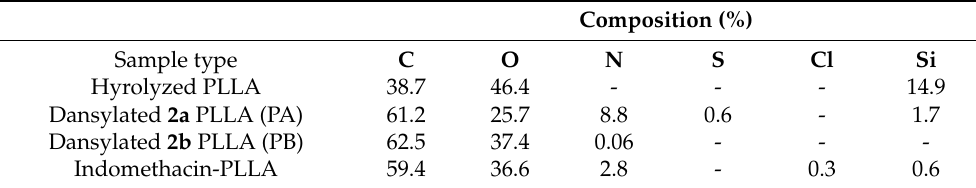
Table 2. The atomic weight percentage of hydrolysed and modified PLLA samples.